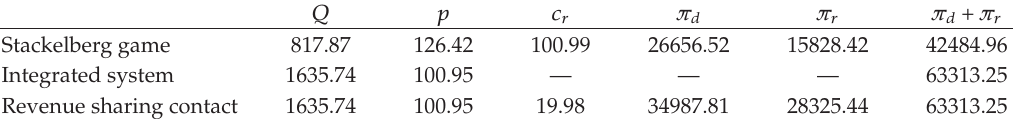
Table 1: Optimal order quantity and price of retailer and distributor under various setting.